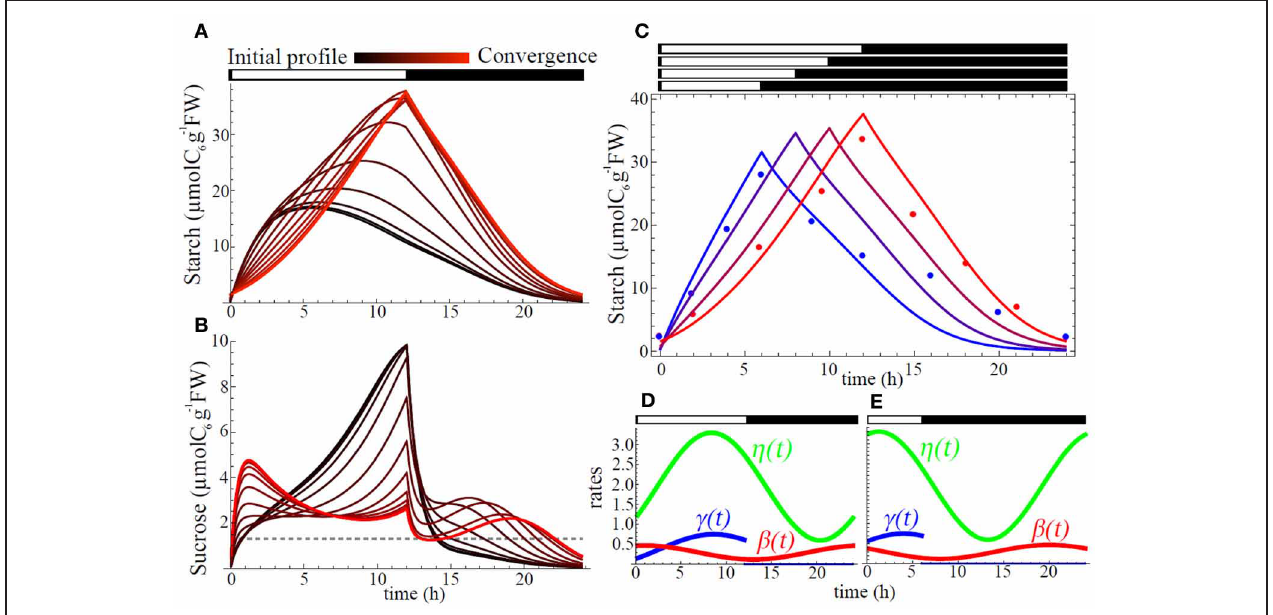
(dark red), and 12h/12h (red). Points are starch data from (2) for SD (blue) and LD (red). Each profile corresponds to an optimal set of phase shifts φ γ , φ β , and φ η for carbon partitioning ( γ ( t ) ), starch degradation ( β ( t ) ), and sucrose export ( η ( t ) ), respectively, obtained after convergence of the starvation minimization process. Profiles for γ ( t ) (blue), β ( t ) (red), and η ( t ) (green) are shown in (D) for LD (12h/12 h) and in (E) for SD (6h/18h)